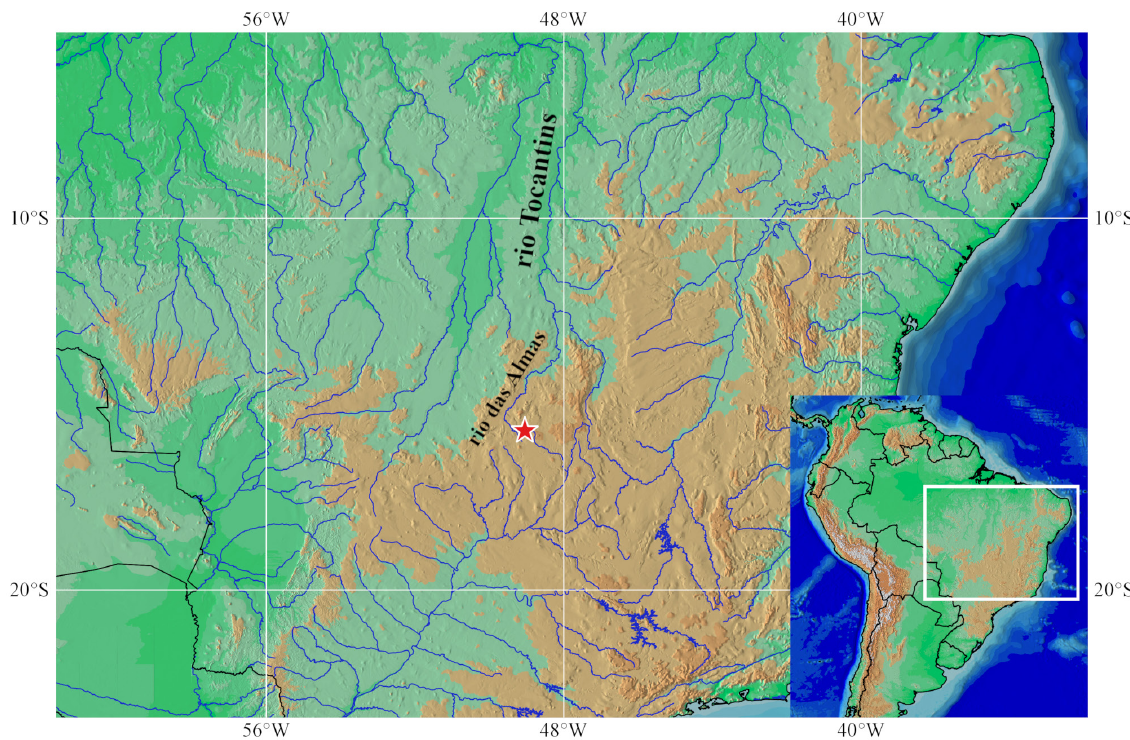
FIGURE 5 | Partial map of South America, showing the known geographic distribution of Knodus rufford and K. obolus . The red star encompasses the type locality and other sampling sites that are too close to be represented as separate